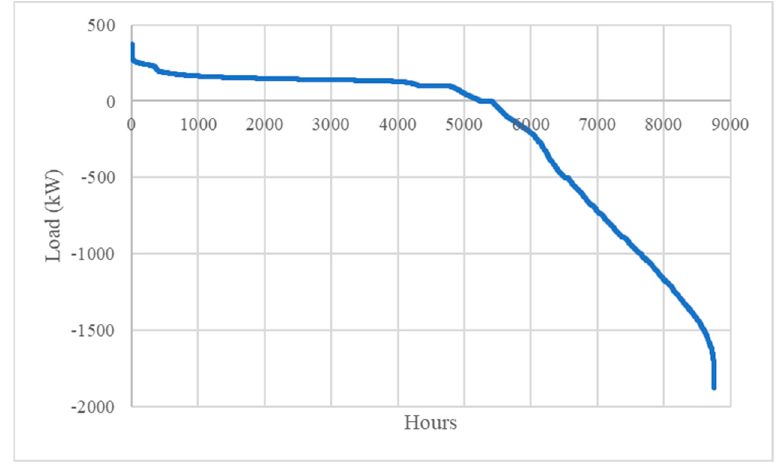
Figure 12. Load duration curve that refers to an external transformer in the HMU campus microgrid (optimal MV station case solution).